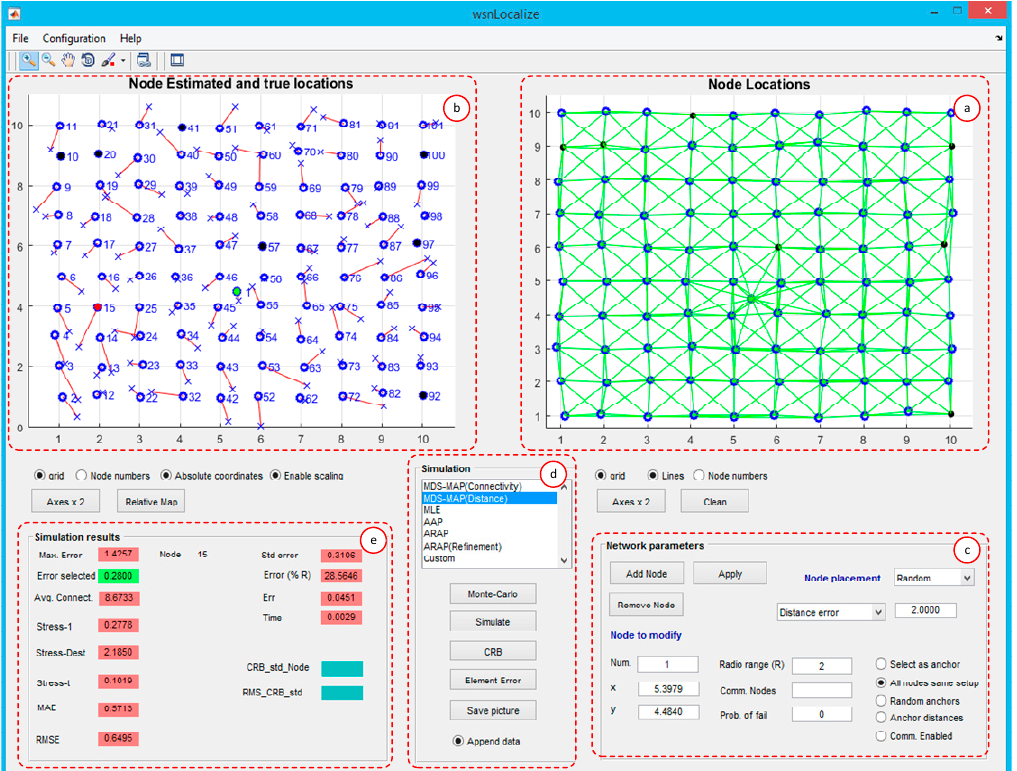
Figure 4. Main window of the developed tool.